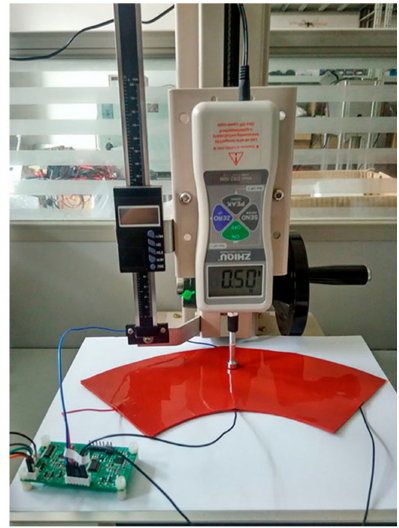
Figure 15. Setup of the contact